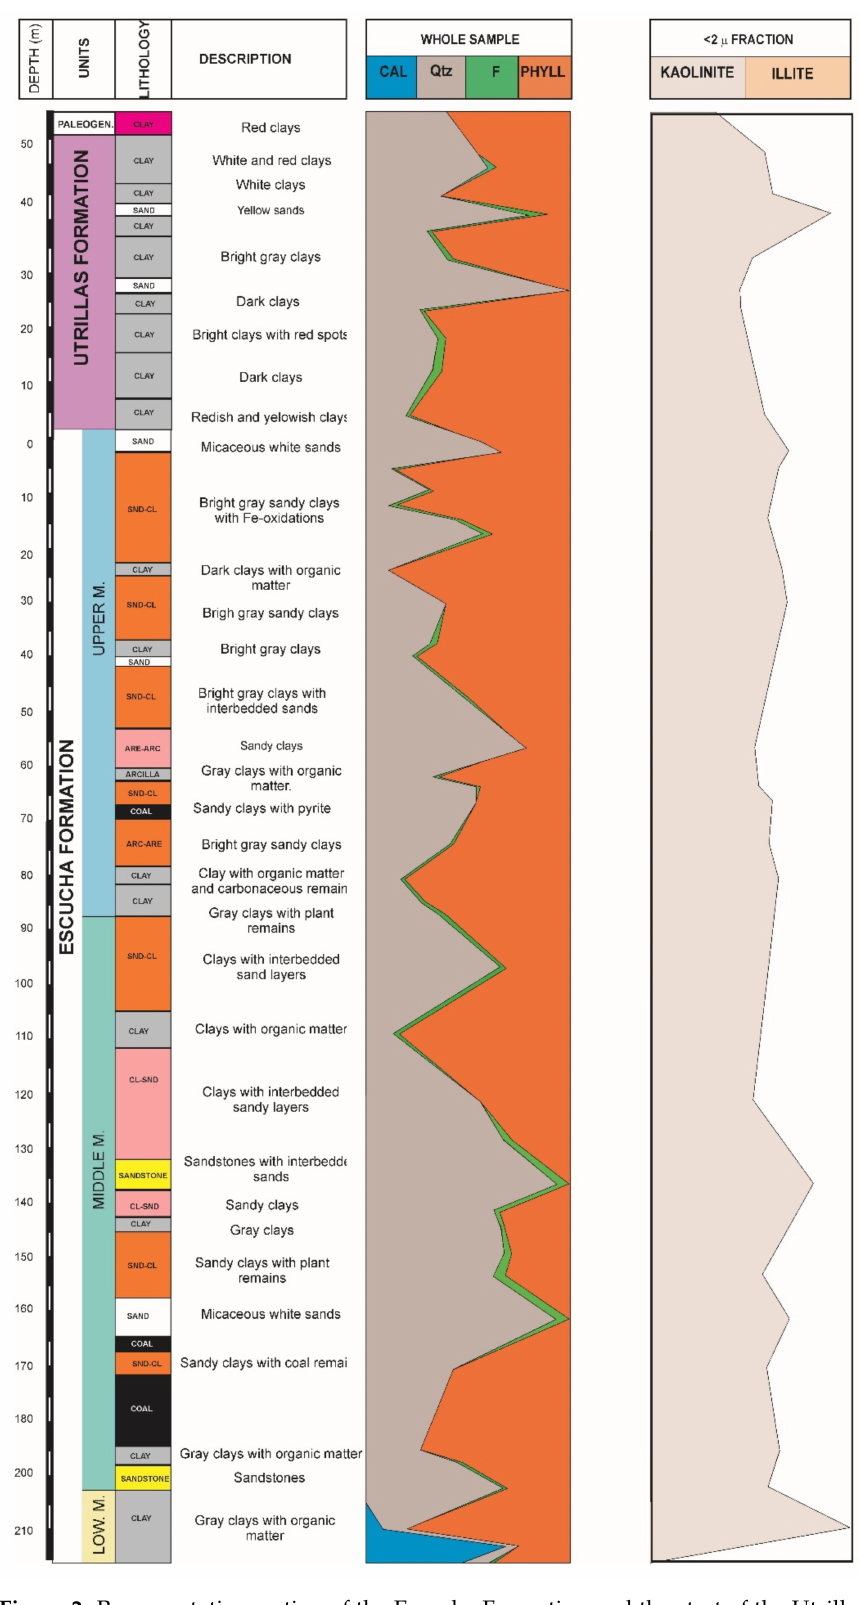
Figure 2. Representative section of the Escucha Formation and the start of the Utrillas Formation (Estercuel-Gargallo subbasin) showing lithologies and mineralogy (XRD) of both the whole sample and the less than 2 µ m fraction. Cal = calcite, Qtz = quartz, F = feldspars, Phyll =